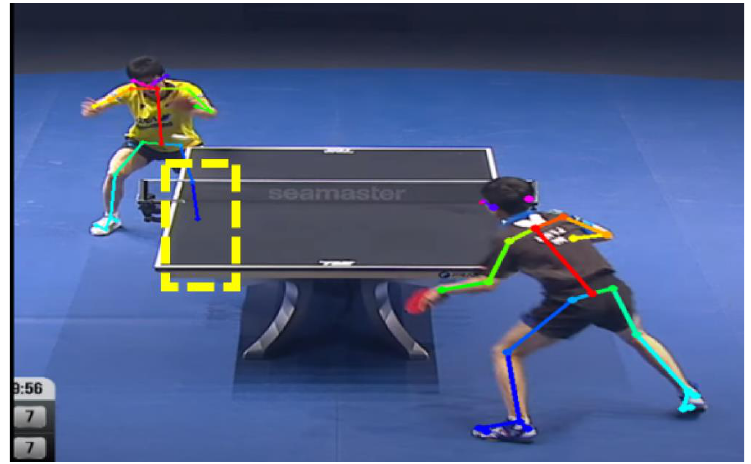
Figure 9. Estimation of foot posture under the table.